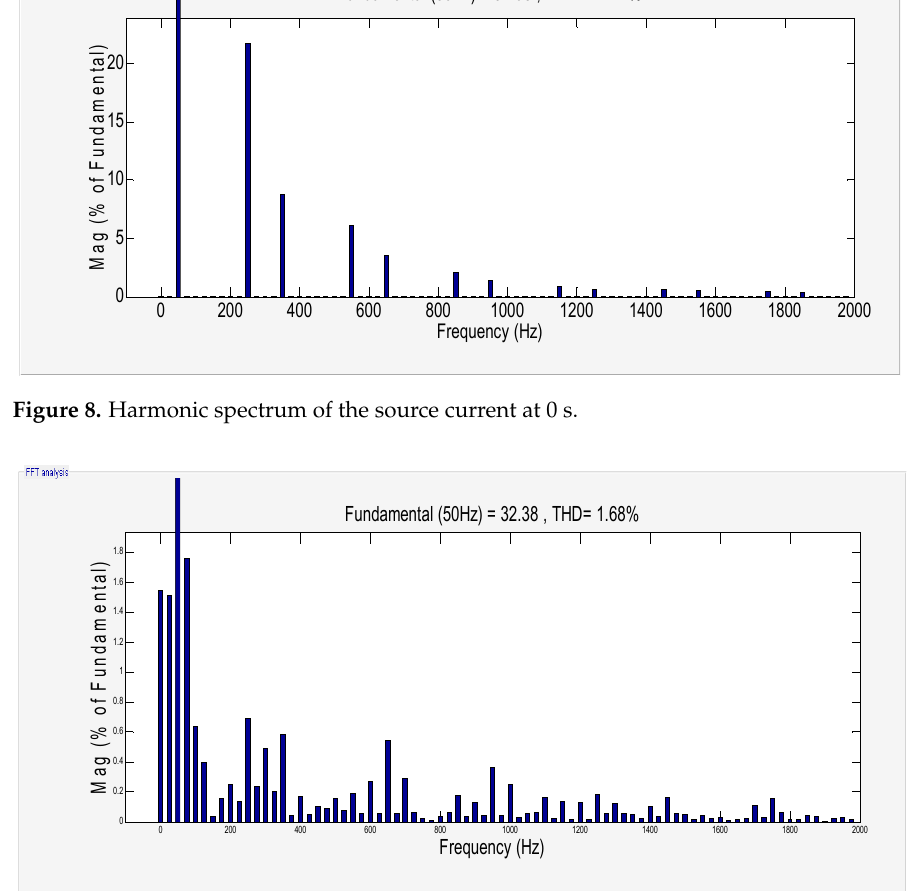
Figure 10. Harmonic spectrum of the source current at 0.16 s. Figure 11. Harmonic spectrum of the source current at 0.26 s.